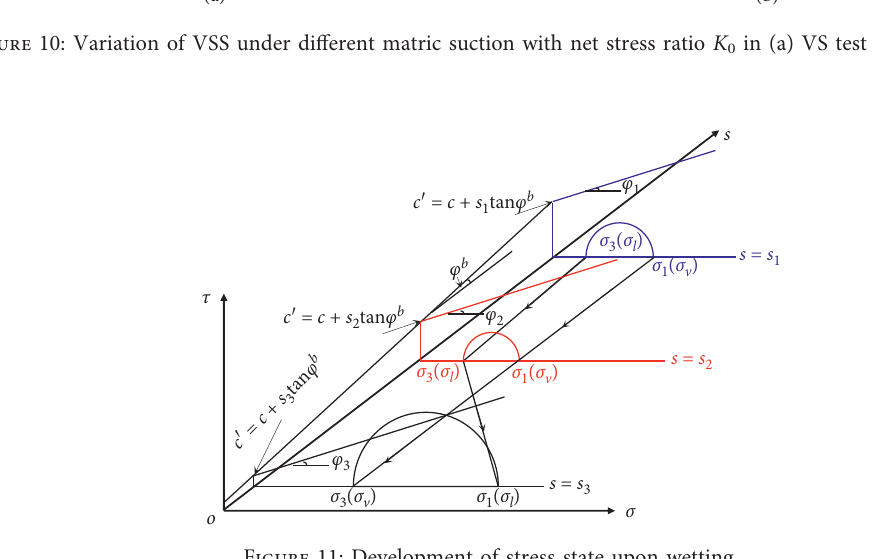
0 in (a) VS test and (b) LS test.